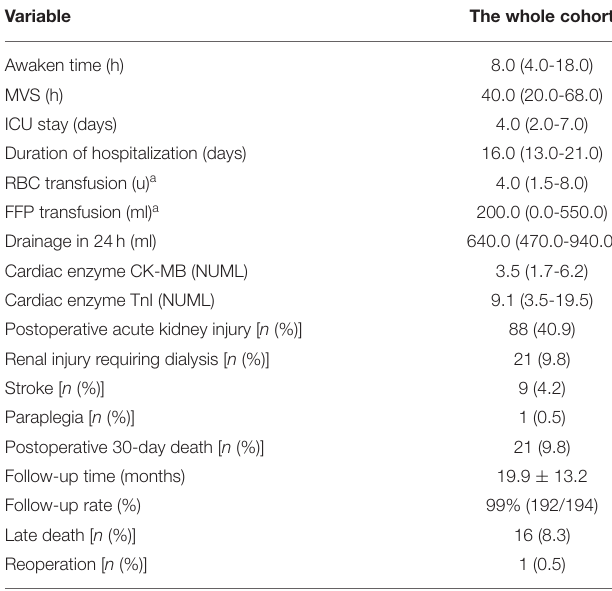
TABLE 2 | Operative characteristics of 215 consecutive patients with ADIAD who underwent treatment using the Brain-Heart-first strategy. Variable